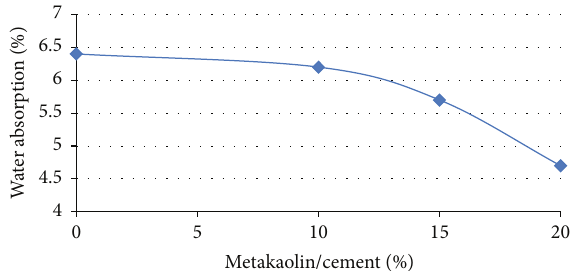
Figure 16: Water absorption at different MK contents and 0%